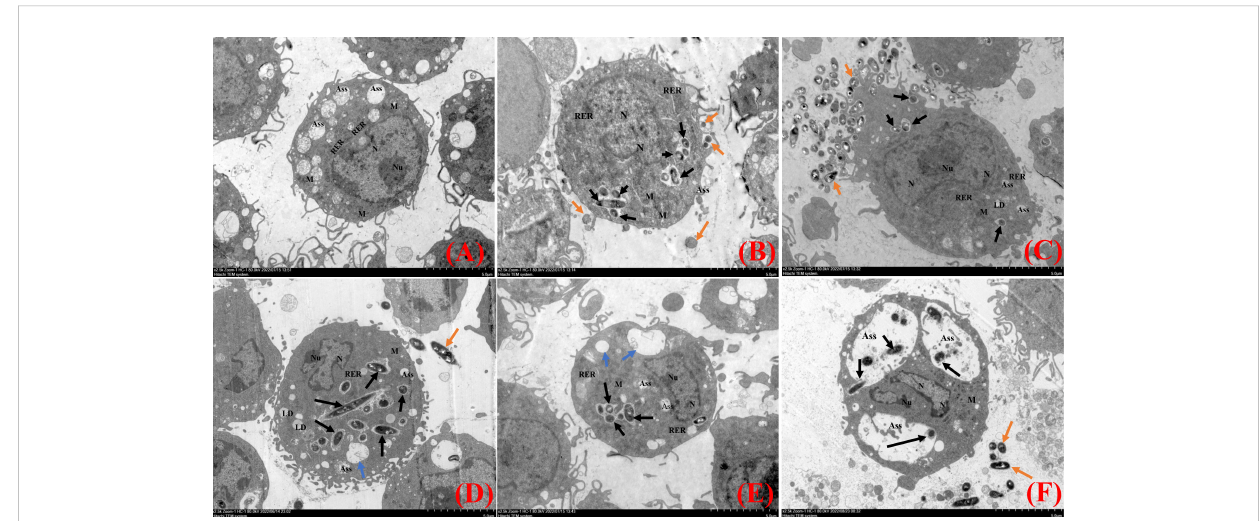
FIGURE 3 Transmission electron microscopy analysis of RAW264.7 infected with N. seriolae. (A) Uninfected cells, (B) 2 hpi, (C) 4 hpi, (D) 6 hpi, (E) 8 hpi, and (F) 12 hpi. Black arrows indicate intracellular bacteria, orange arrows indicate extracellular bacteria, and blue arrows indicate cell